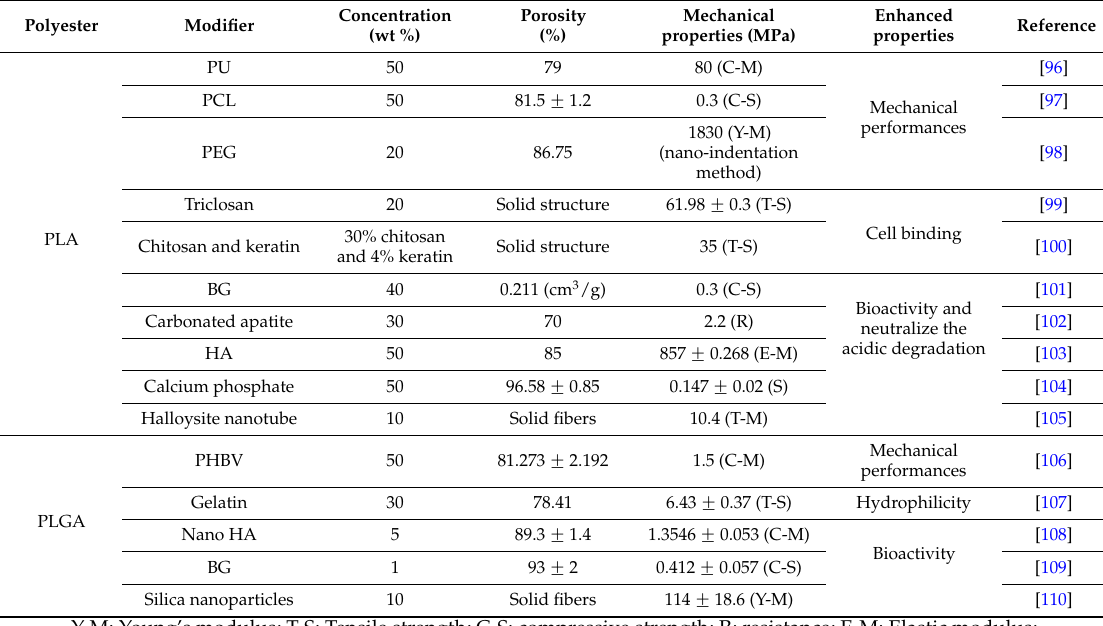
Table 4. Polylactic acid (PLA)-based structures applied in biomedical and tissue engineering applications.